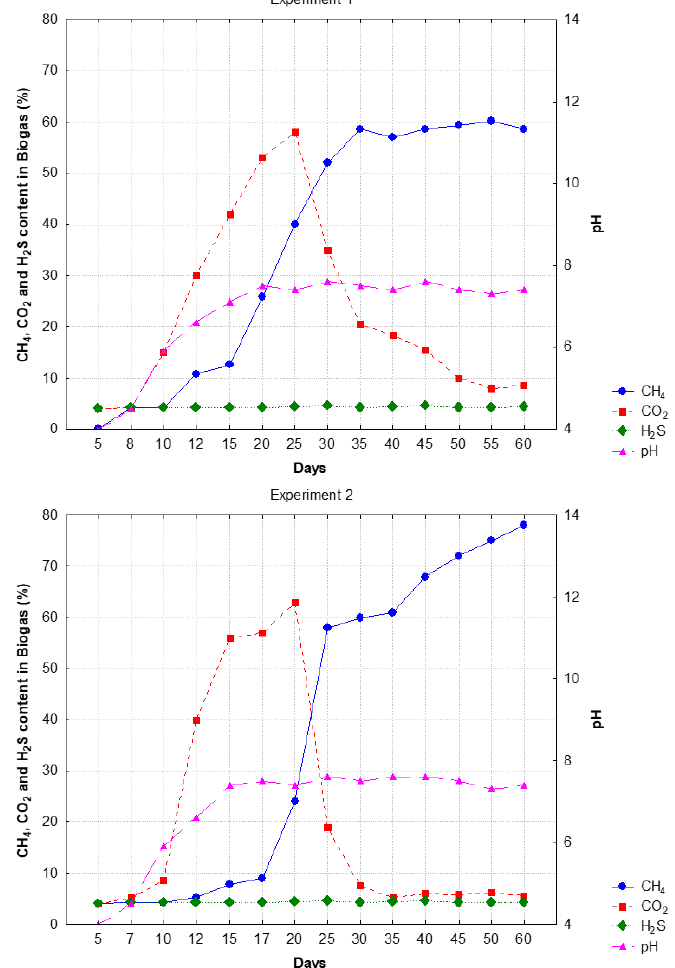
Figure 7. Biogas production profile obtained during the 60 days of experiments. Experiment 1: Bioprocess operating in batch system and Experiment 2: Bioprocess operating in semi-continuous system.